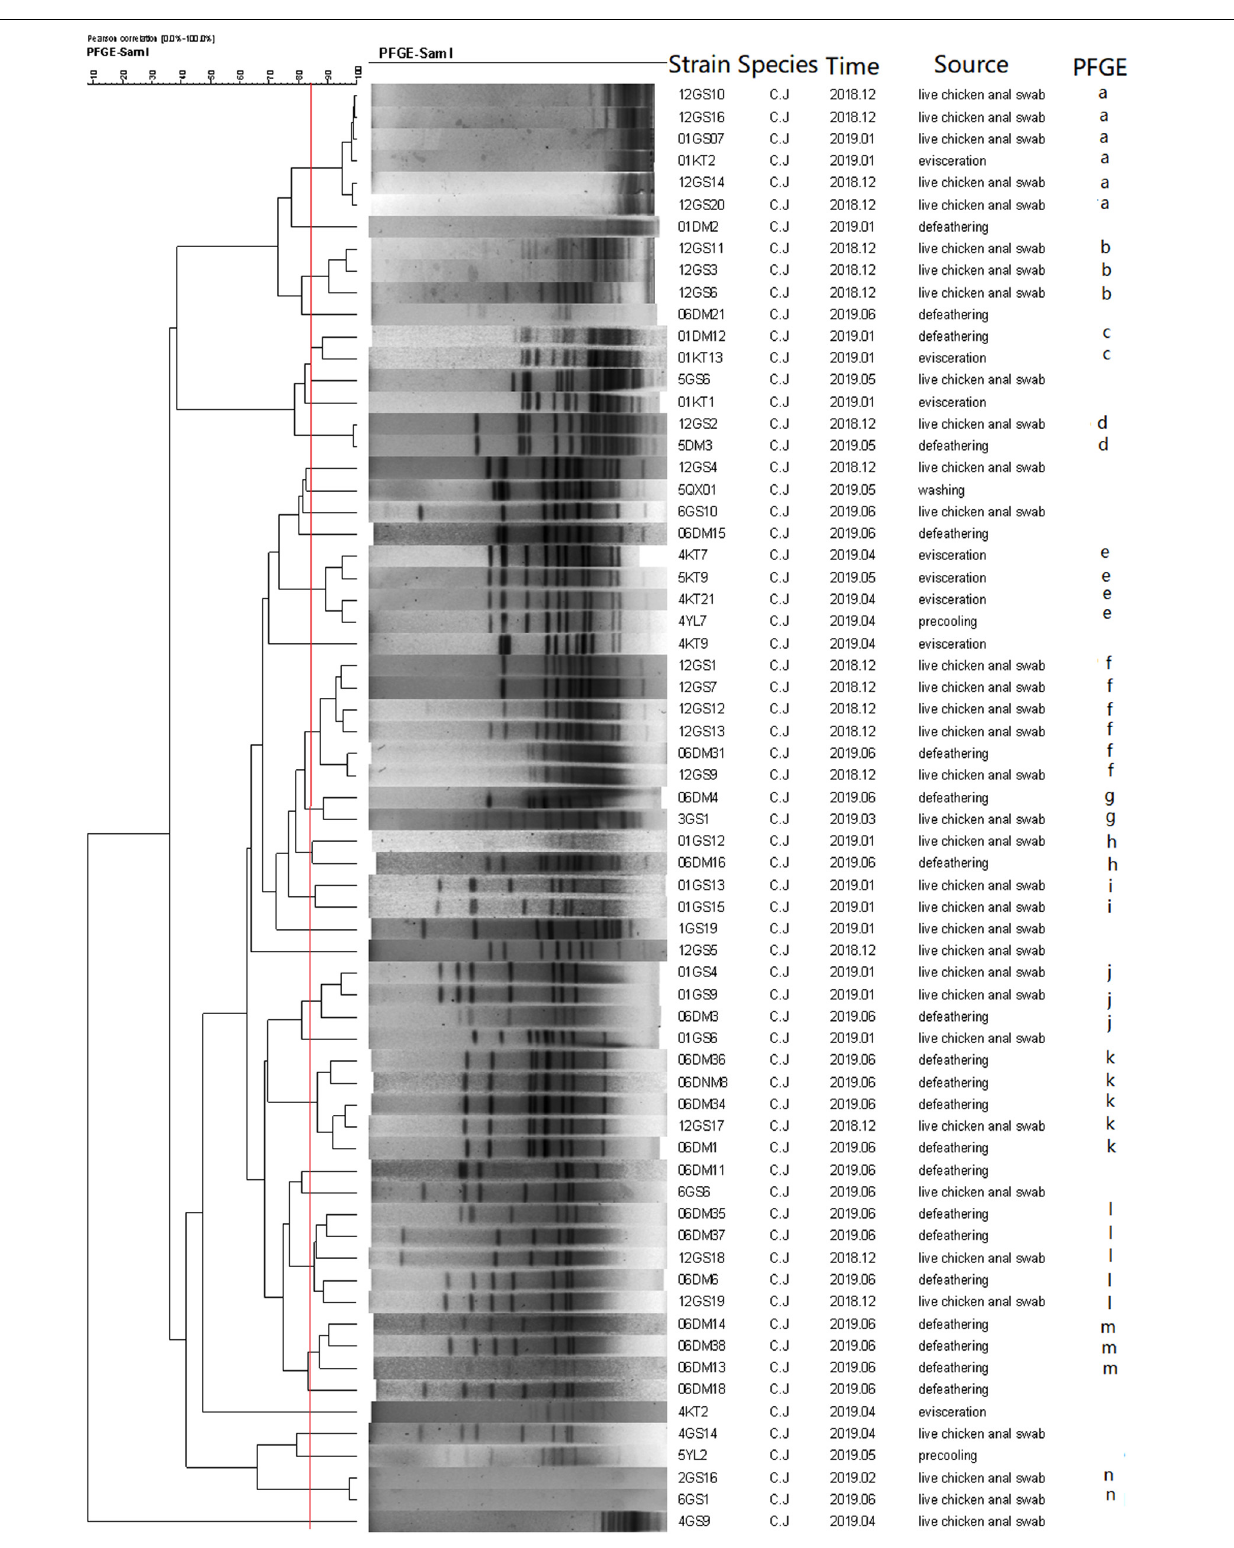
Frontiers in Microbiology |